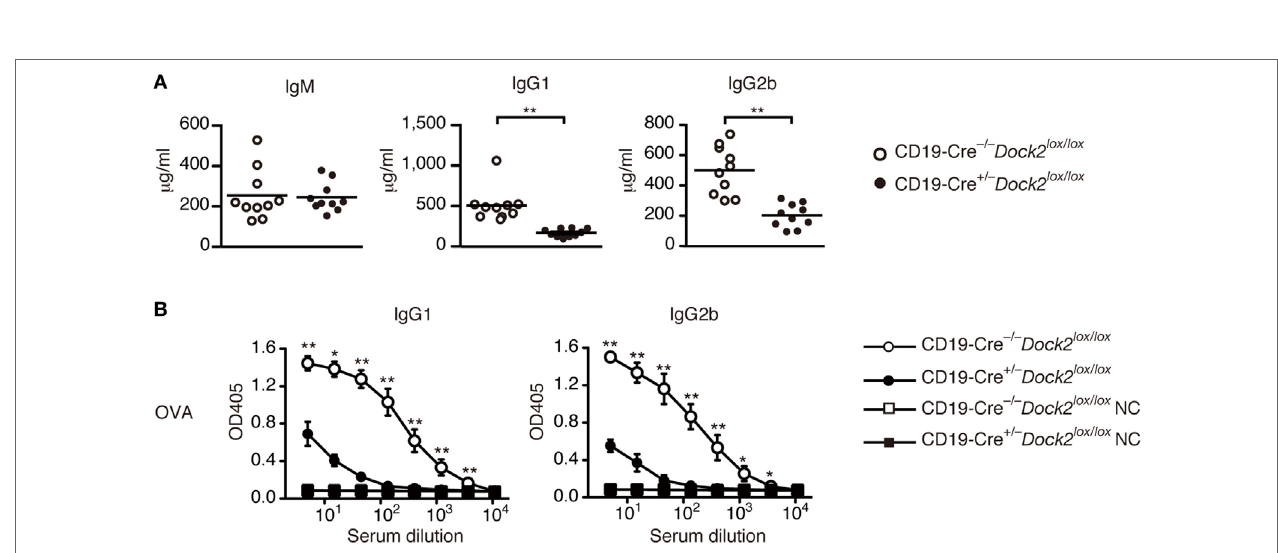
FigUre 5 | Characterization of CD19-Cre + / − Dock2 lox/lox mice. (a) FACS profiles for expression of IgM and IgD in the CD19 + bone marrow B cells. The number of each subset of B cells was compared between CD19-Cre − / − Dock2 lox/lox and CD19-Cre + / − Dock2 lox/lox mice. Data are indicated as the mean ± SD of five mice. ** p < 0.01 (two-tailed Mann–Whitney test). (B) FACS profiles for expression of IgM and IgD in the B220 + splenic B cells. The number of each subset of B cells was compared between CD19-Cre − / − Dock2 lox/lox and CD19-Cre + / − Dock2 lox/lox mice. Data are indicated as the mean ± SD of 5 mice. ** p < 0.01 (two-tailed unpaired Student’s t -test). (c) FACS profiles for expression of CD21 and heat stable antigen (HSA) in the B220 + splenic B cells. The number of each subset of B cells (T1, T2, and follicular B cells) was compared between CD19-Cre –/– Dock2 lox/lox and CD19-Cre + / − Dock2 lox/lox mice. Data are indicated as the mean ± SD of five mice. * p < 0.05; ** p < 0.01 (two-tailed Mann–Whitney test). (D) FACS profiles for expression of IgM and IgD or CD21 and HSA in the B220 + peripheral LN (PLN) B cells. The number of each subset of B cells was compared between CD19-Cre − / − Dock2 lox/lox and CD19-Cre + / − Dock2 lox/lox mice. Data are indicated as the mean ± SD of five mice. * p < 0.05; ** p < 0.01 (two-tailed Mann–Whitney test). (e) Immunohistochemical analyses of the spleen sections from CD19-Cre − / − Dock2 lox/lox and CD19-Cre + / − Dock2 lox/lox mice.